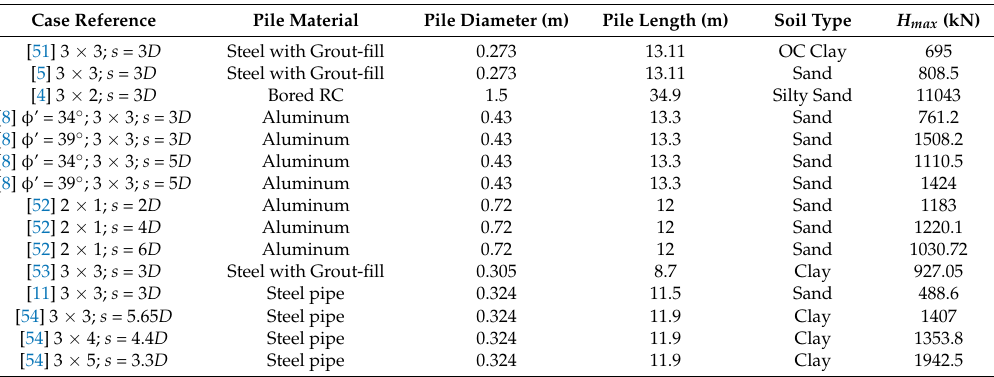
Table 1. Case histories studied.